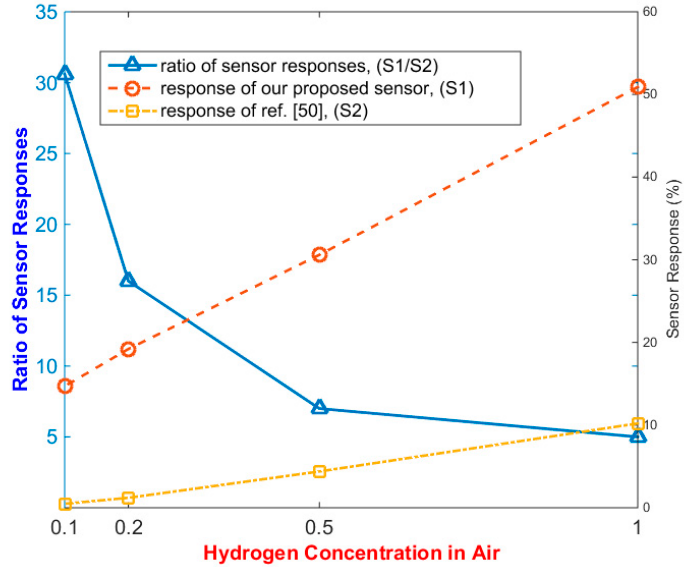
Figure 7. The response of our proposed hydrogen sensor based on 1.7 nm nanoparticles in comparison with the reference [50] in volume concentrations 0.1%, 0.2%, 0.5%, and 1% of hydrogen in ambient air, and the ratio of the response of our sensor to that of the reference